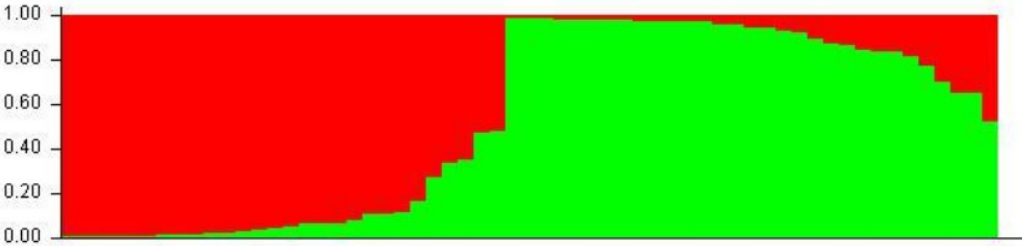
Figure 3. STRUCTURE output for sunflower association panel with K=2 clusters based on 34 polymorphic SSR primer combinations. Two subpopulations were identified in the sunflower association panel composed of 59 accessions in total. The first subpopulation (sp1) is labeled with red color and the second subpopulation (sb2) with green color.